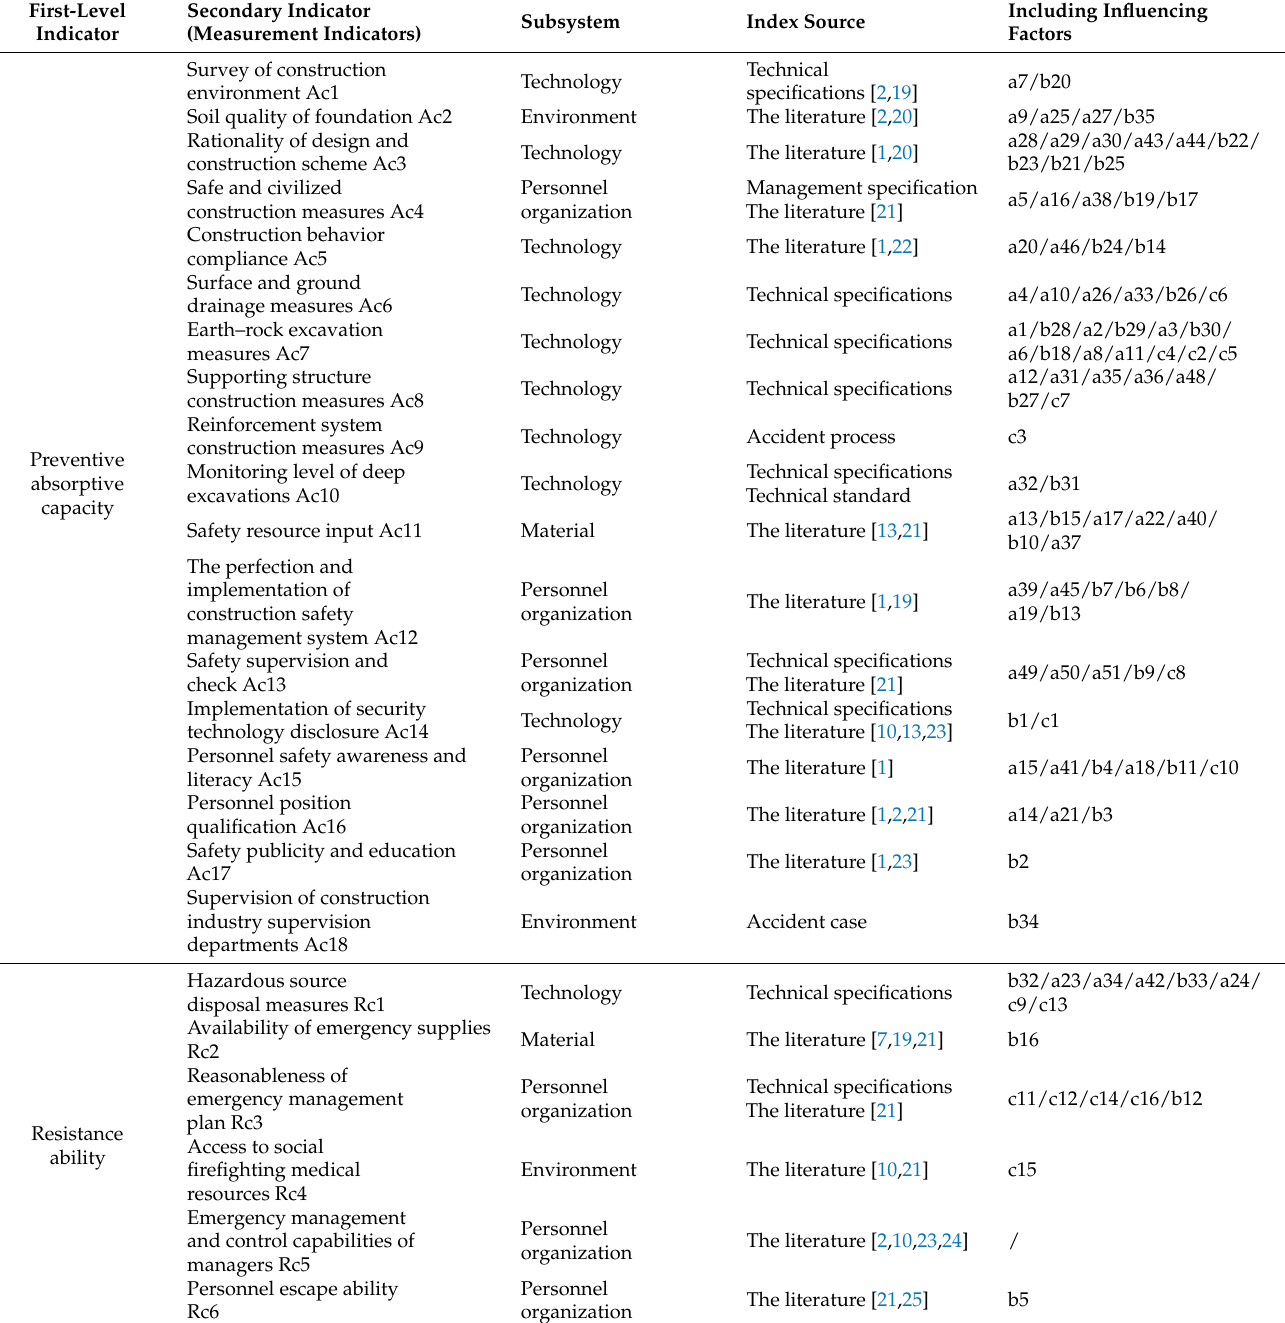
Table 2. Initial resilience evaluation index system of